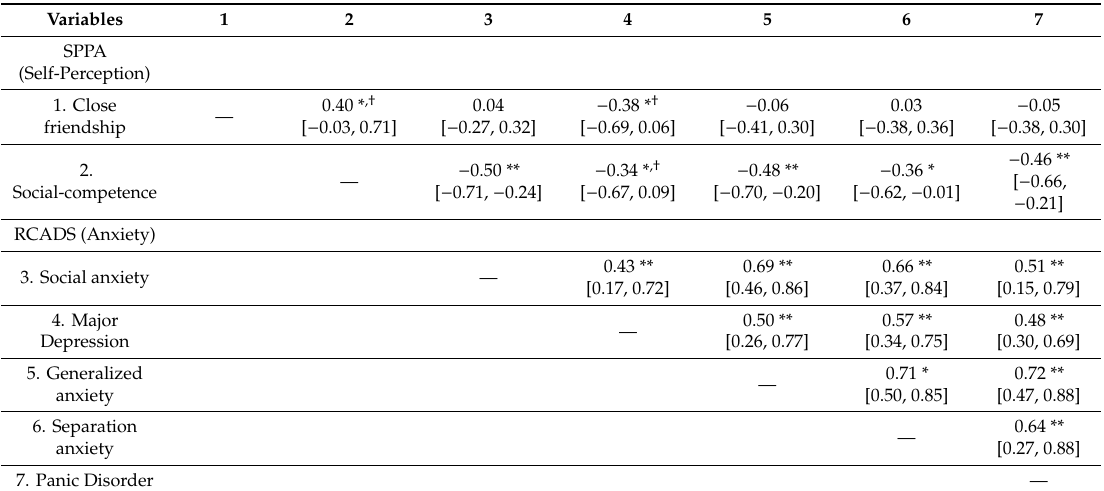
Table 3. Correlation matrix for all study variables for non-immigrant adolescents ( n = 36). 95% percentile bootstrap confidence intervals in